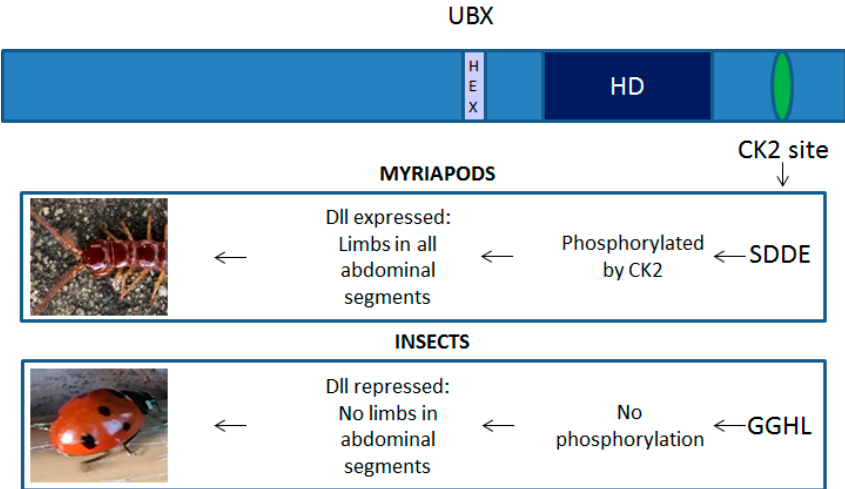
Figure 2. Casein kinase 2 (CK2) phosphorylation is a key regulator of Ultrabithorax (UBX) function. Phosphorylation of UBX by CK2 prevents it from repressing Ditsal-less (Dll) transcription in lower arthropods and consequently all embryonic segments posterior to the head give rise to limbs. This CK2 site is lost in insects and as a result UBX represses Dll expression, leading to the suppression of limb formation in the abdominal segments.